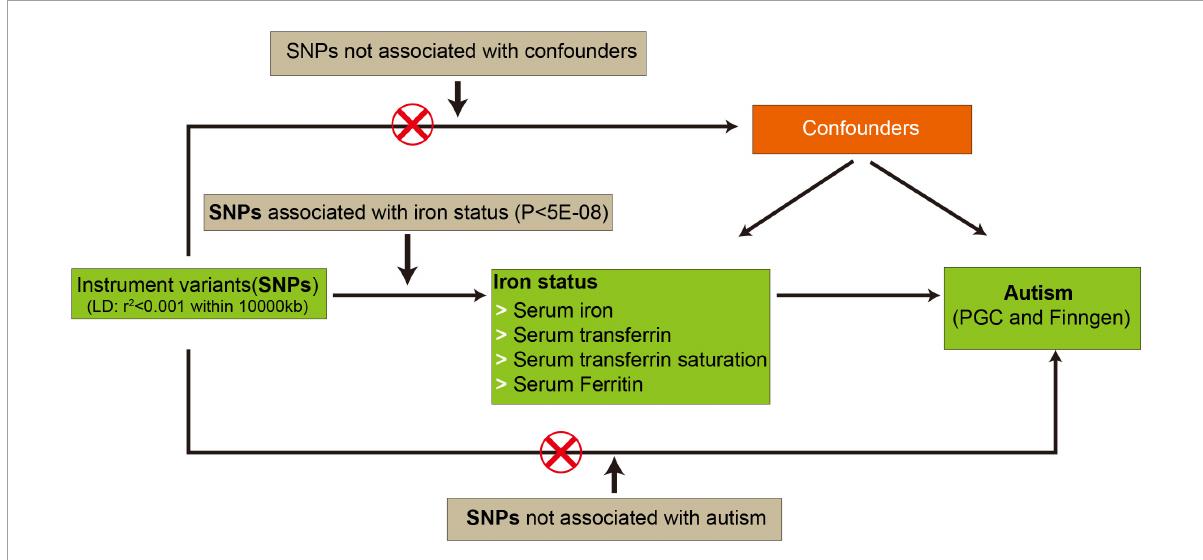
FIGURE1 The flowchart in this two-sample Mendelian randomization study. The red cross means that genetic variants are not associated with confounding factors and outcomes. PGC, psychiatric genomics consortium; SNPs, single nucleotide